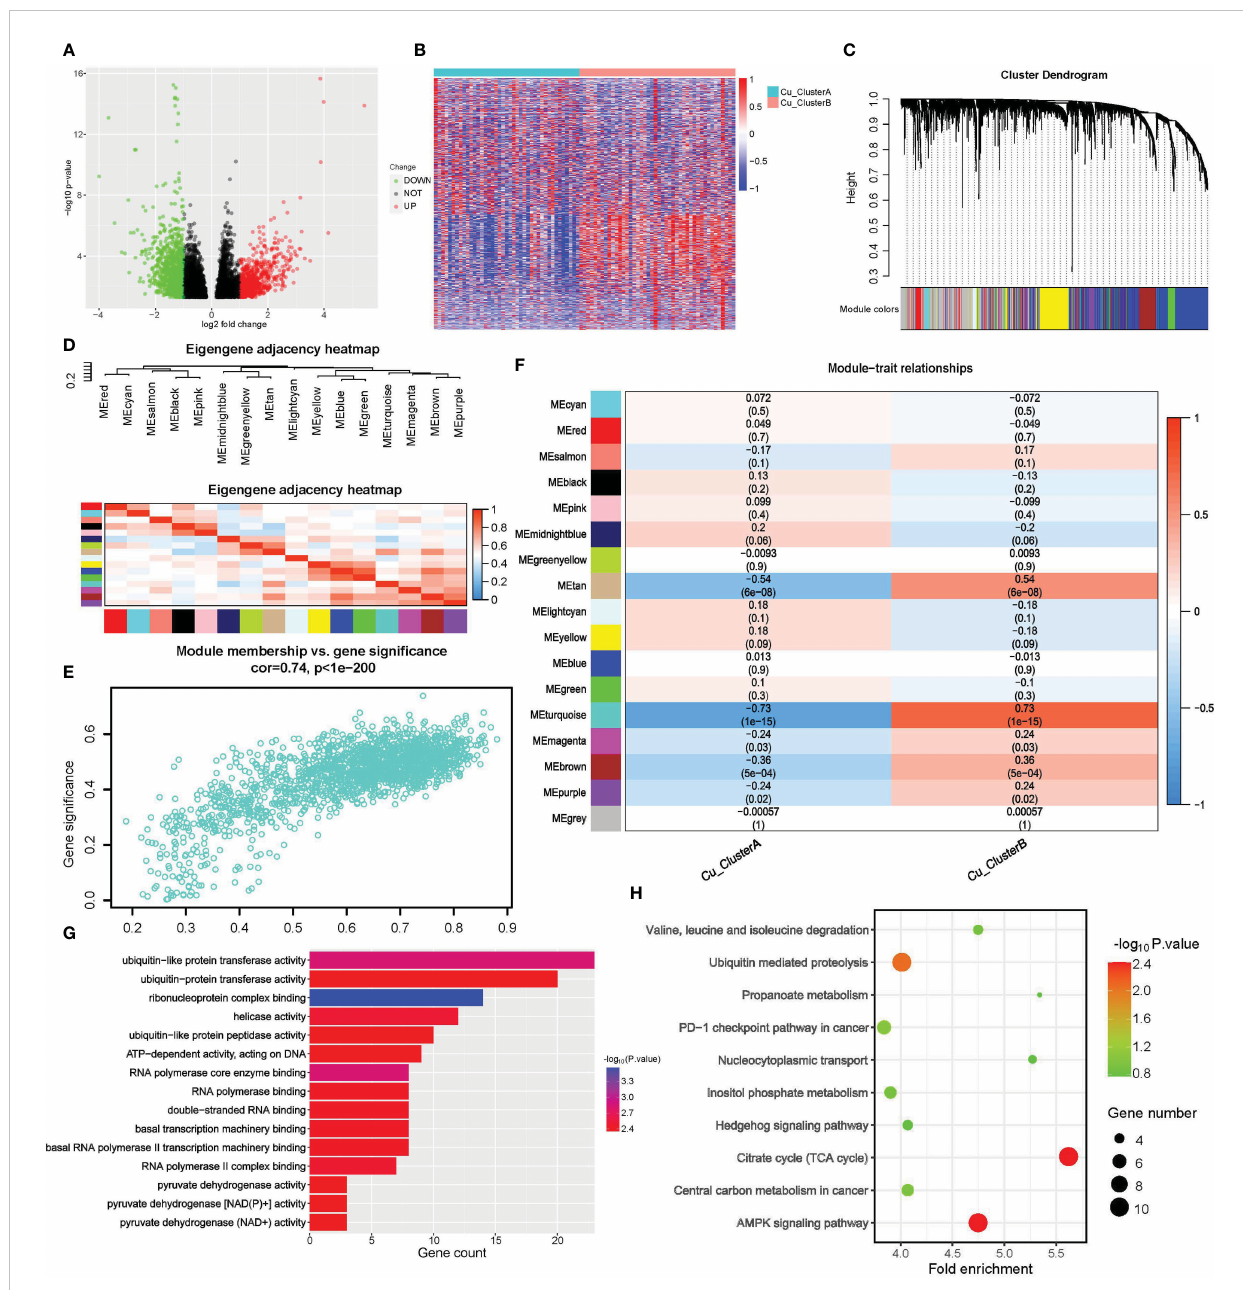
FIGURE 3 Screening of cuproptosis-related genes by DE analysis and WGCNA. (A, B) Results of DE analysis in different Cu_Cluseters; (A) Volcano plot of DEGs; (B) Heatmap of DEGs. (C – F) WGCNA analysis for DEGs to identify gene module that was most correlated with Cu_Clusters; (G, H) Pathway enrichment analysis for hub genes obtained from WGCNA; (G) Molecular function analysis of WGCNA hub genes in GO (H) Pathway enrichment analysis of WGCNA hub genes in